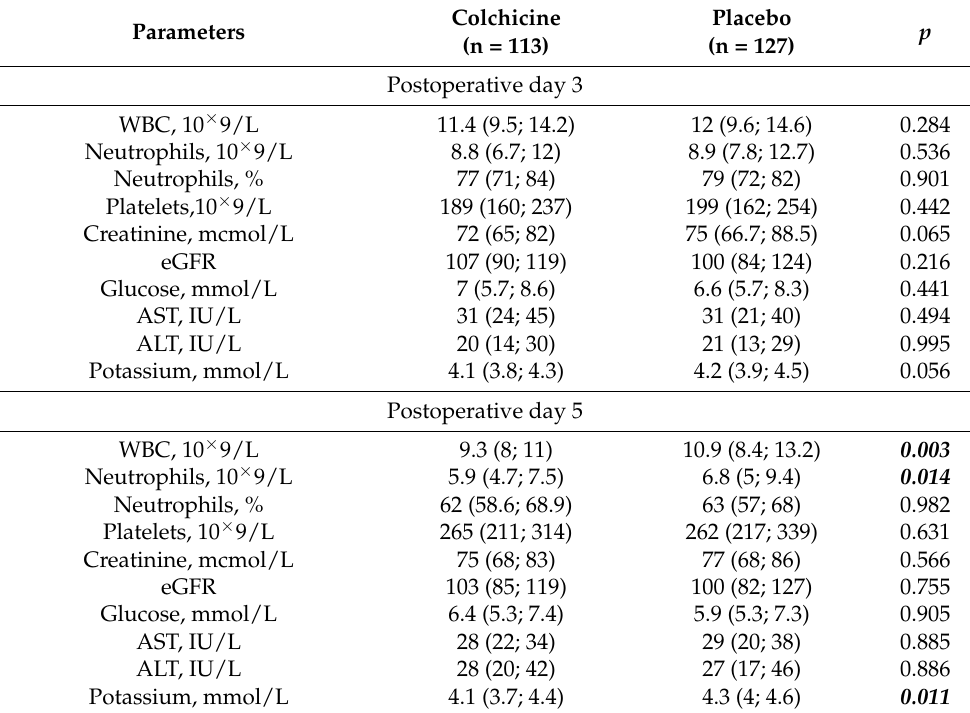
Table 6. Postoperative laboratory test results.